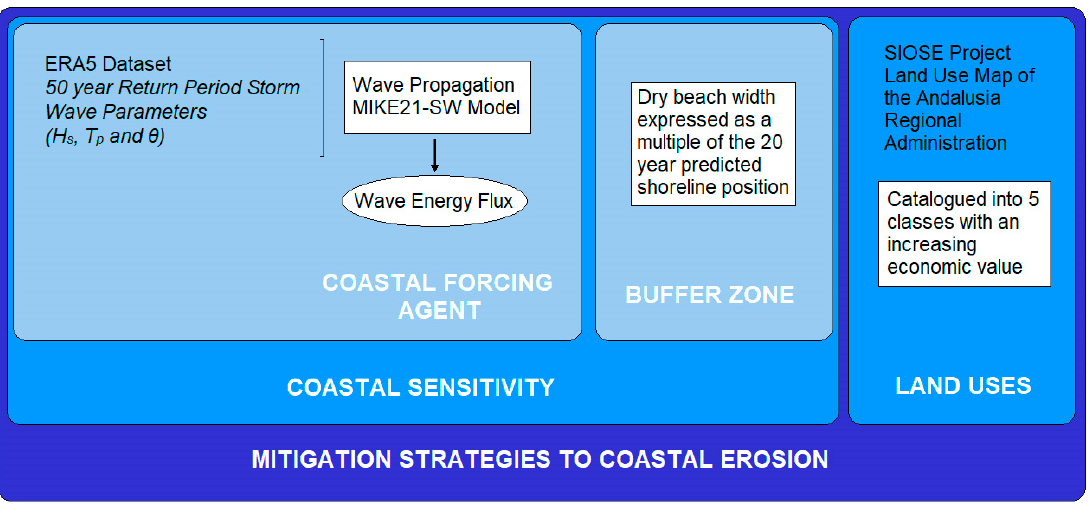
Figure 2. Summary of the methodology used in this